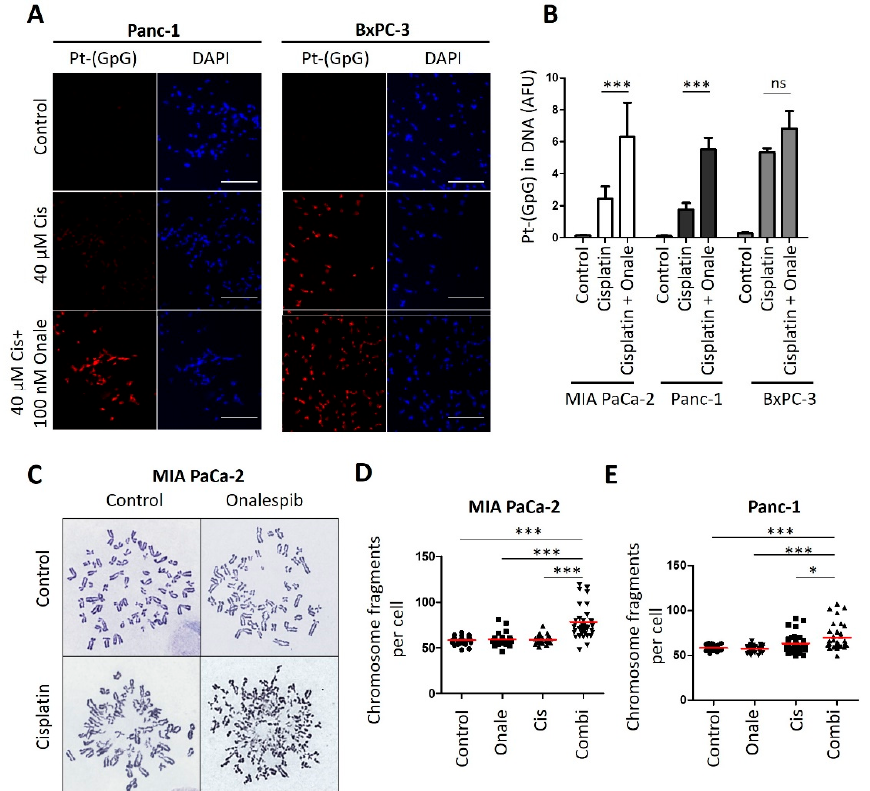
Figure 4. Cisplatin-resistant PDAC cells reveal increased platinum-DNA adduct formation and DNA damage after combining cisplatin and HSP90 inhibitor. ( A ) Representative images of the staining of platinated DNA in resistant Panc-1 and sensitive BxPC-3 cells after 5 h of cisplatin treatment, with a preincubation for 24 h with 100 nM onalespib. Scale bar, 200 µm. ( B ) Platinum-adduct level quantification of pancreatic cancer cell lines measured from ( A ). Mean ± SD of 3 biological replicates. p values were calculated with two-way ANOVA comparing the indicated groups. ( C ) Representative images of metaphase spreads. MIA PaCa-2 cells were treated with onalespib (100 nM) and/or cisplatin (20 µ M) for 24 h, along with 20 µ M zVAD to block apoptosis. Chromosomes were stained with Giemsa. ( D , E ) Number of ( D ) MIA PaCa-2 and ( E ) Panc-1 chromosome fragments per cell, shown as scatter plot and analyzed in 40 randomly chosen cells from three independent experiments. Panc-1 cells were treated as the MIA Paca-2 cells from ( C ). Red lines indicate the mean. p values were calculated with 1way ANOVA comparing the indicated groups. ns = not significant, * p ≤ 0.05, and *** p ≤